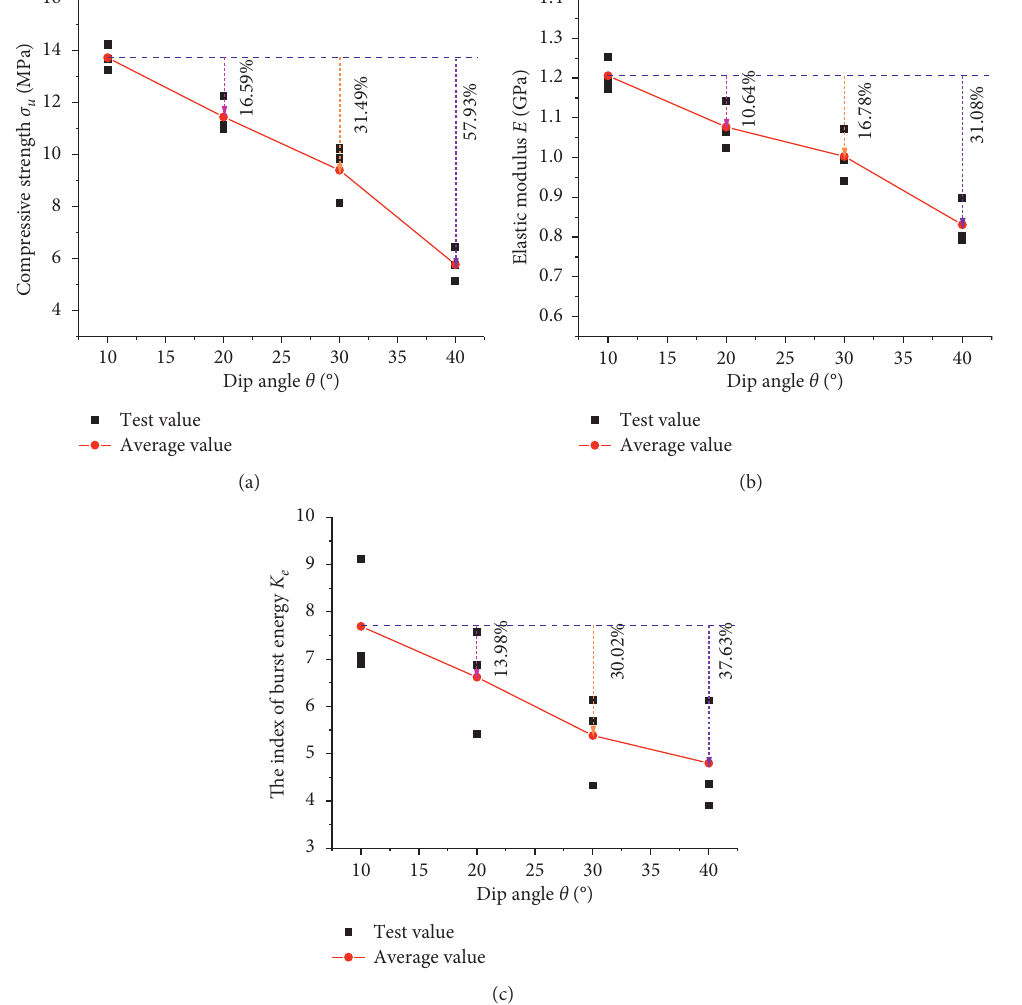
Figure 8: Test results of the mechanical parameters of composite specimens with different dip angles. (a) Uniaxial compressive strength. (b) Elastic modulus. (c) Bursting energy